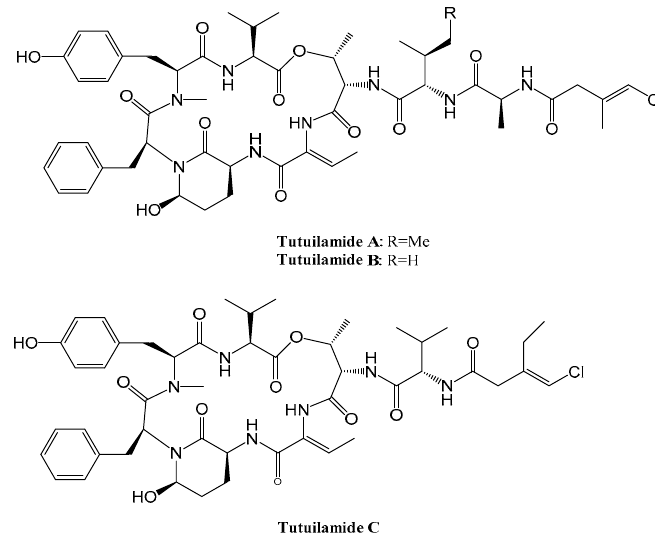
Figure 5. Structures of Tutuilamides A–C.